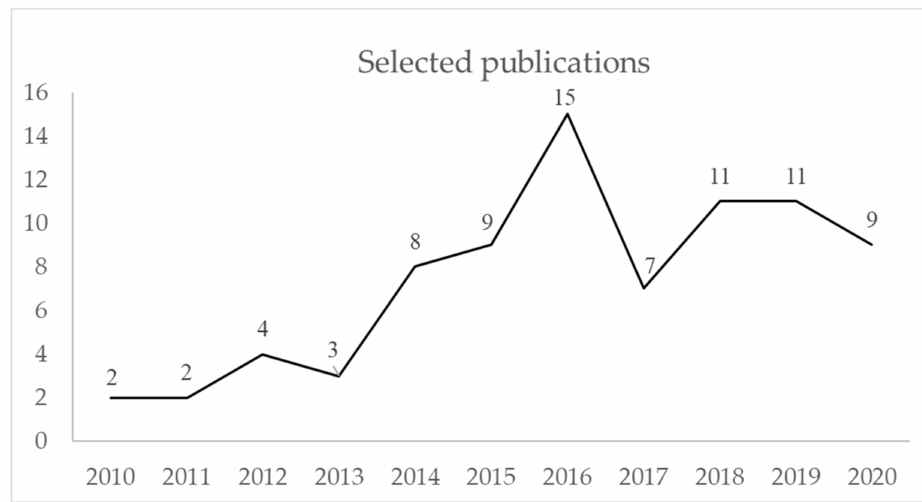
Figure 5. Selected publications sorted by publication